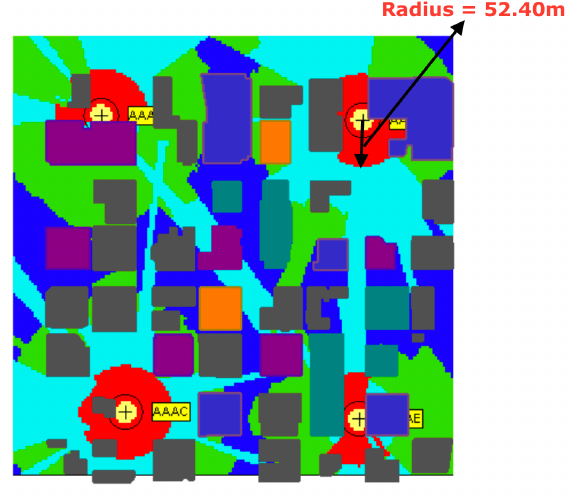
Figure 10. Heuristic site location for outdoor with SISO antennas.